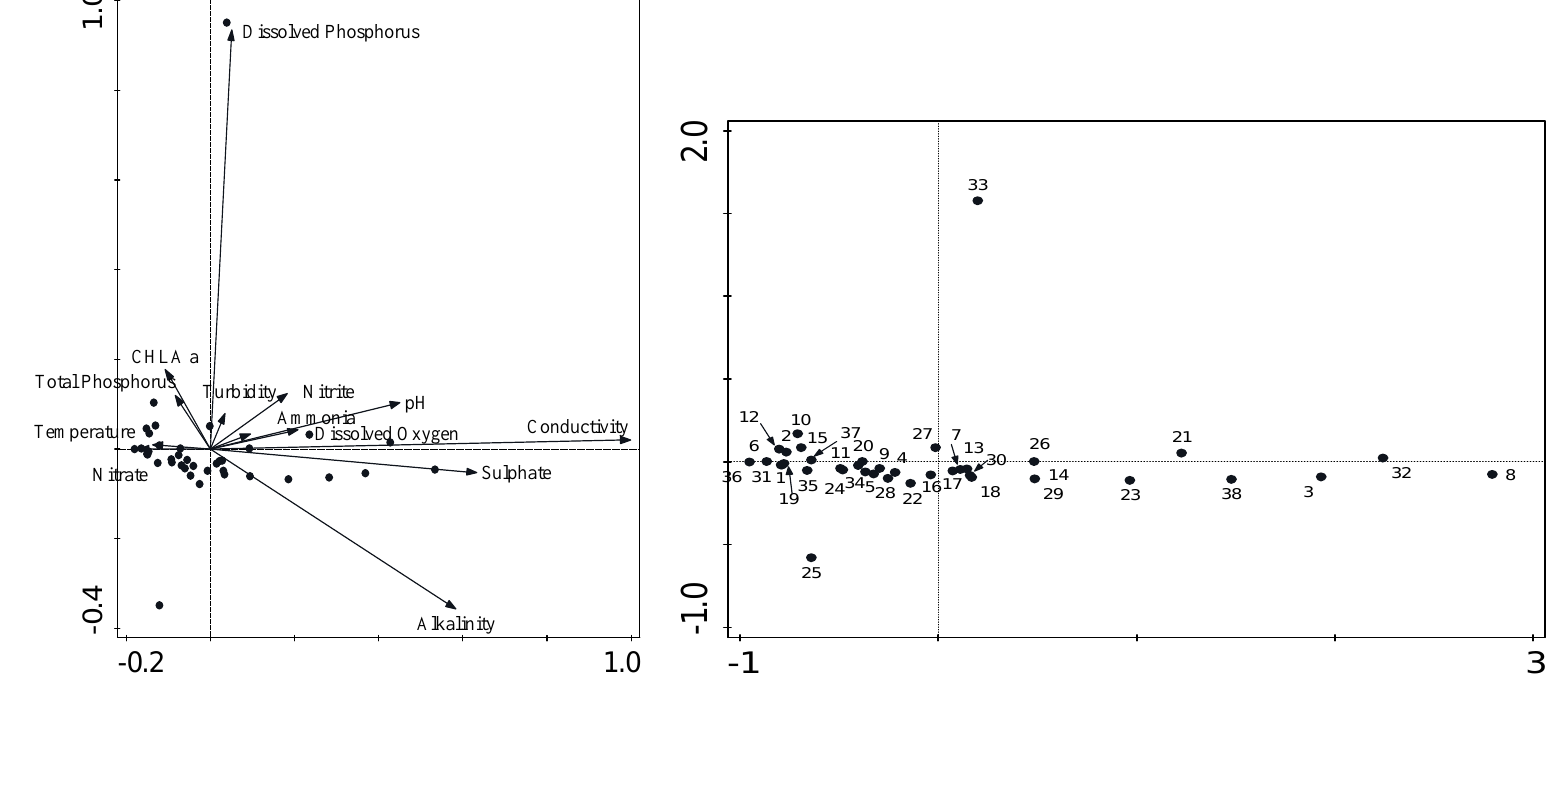
Figure 3: Principal Components Analysis (PCA) ordination diagram of the 38 study sites (list given under the Figure 2.) and associated environmental variables during the dry season (a=distribution of environmental variable; b=distribution of